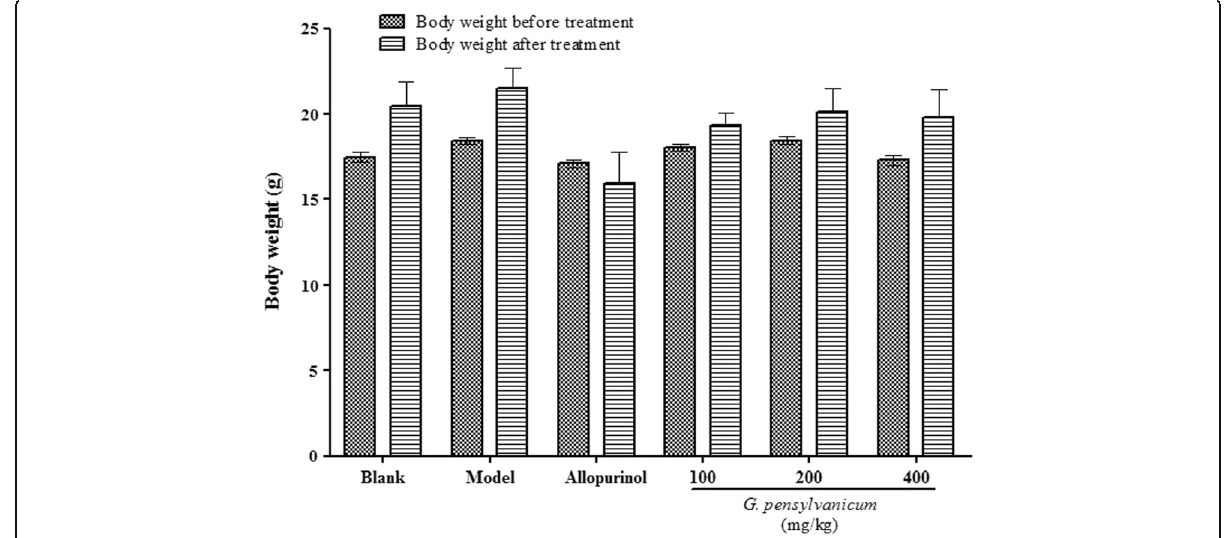
Fig. 2 Effects of G. pensylvanicum on body weights of hyperuricemia mice. Data are expressed as mean ± SEM ( n =